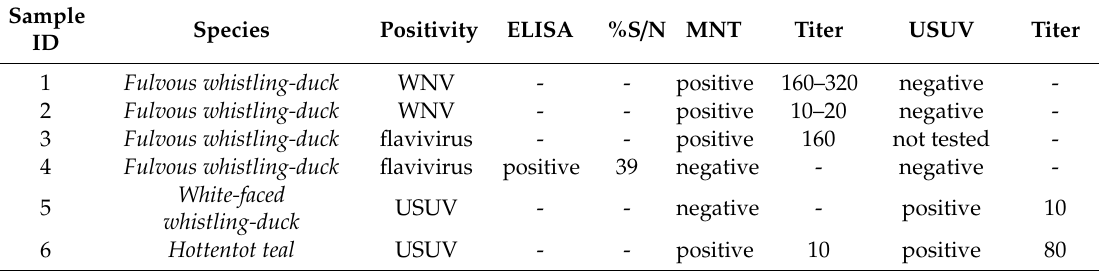
Table 3. Species, positivity for WNV, USUV or undetermined flavivirus, and results associated with ELISA (%S / N), MNT (titer) for the 6 wild birds detected positive in Madagascar. Sample